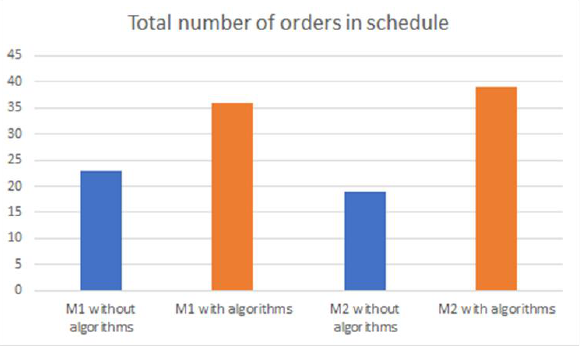
Figure 10. The performance of the total number of orders for each machine.